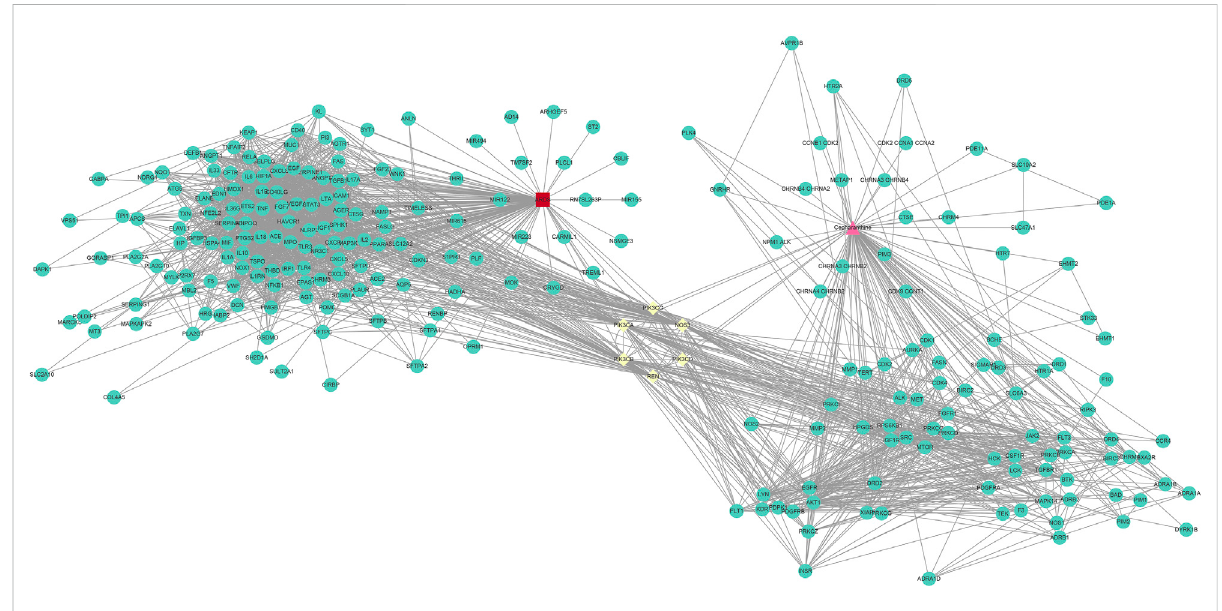
FIGURE 3 PPI network of CEP ’ s targeted genes and genes associated with